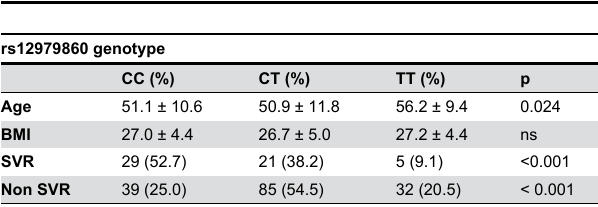
Table 3. Clinical characteristics of 211 patients with chronic hepatitis C, treatment with standard PEG-IFN/RBV, according to the rs12979860 genotype.